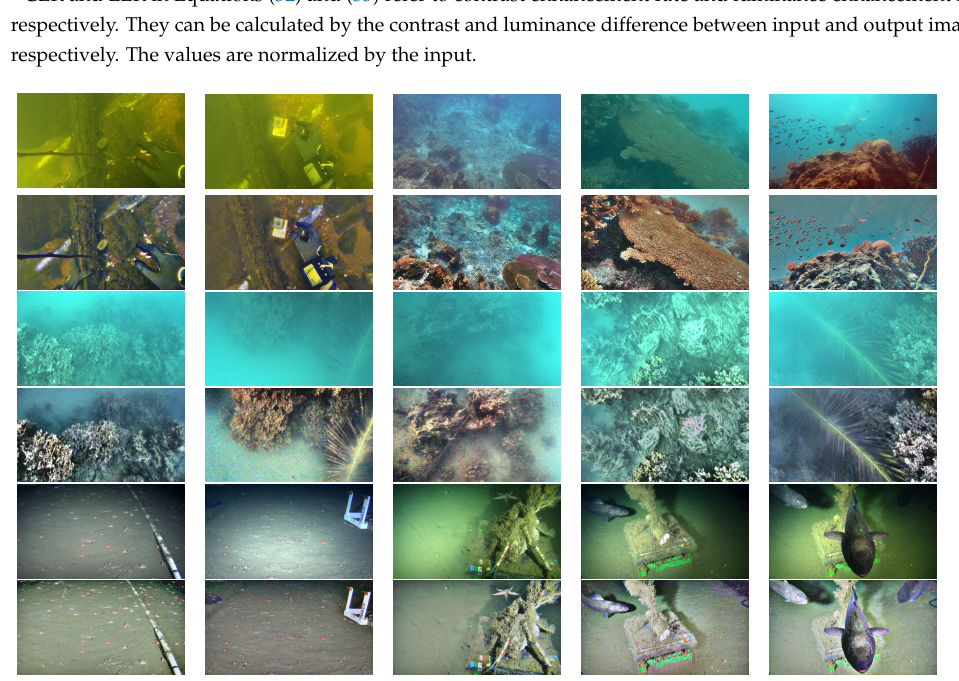
Figure 12. Images for quantitative evaluation. Top two rows: UIEB-65, UIEB-66, UIEB-99, UIEB- 416, UIEB-715 from the UIEB dataset and corresponding post-enhancement images; Middle two rows: images numbered HIMB-1 to HIMB-5 from the Stereo Underwater Image Dataset and their corresponding post-enhancement images; Bottom two rows: OceanDark-2, OceanDark-5, OceanDark-145, OceanDark-155, OceanDark-164 from the OceanDark dataset and corresponding post-enhancement